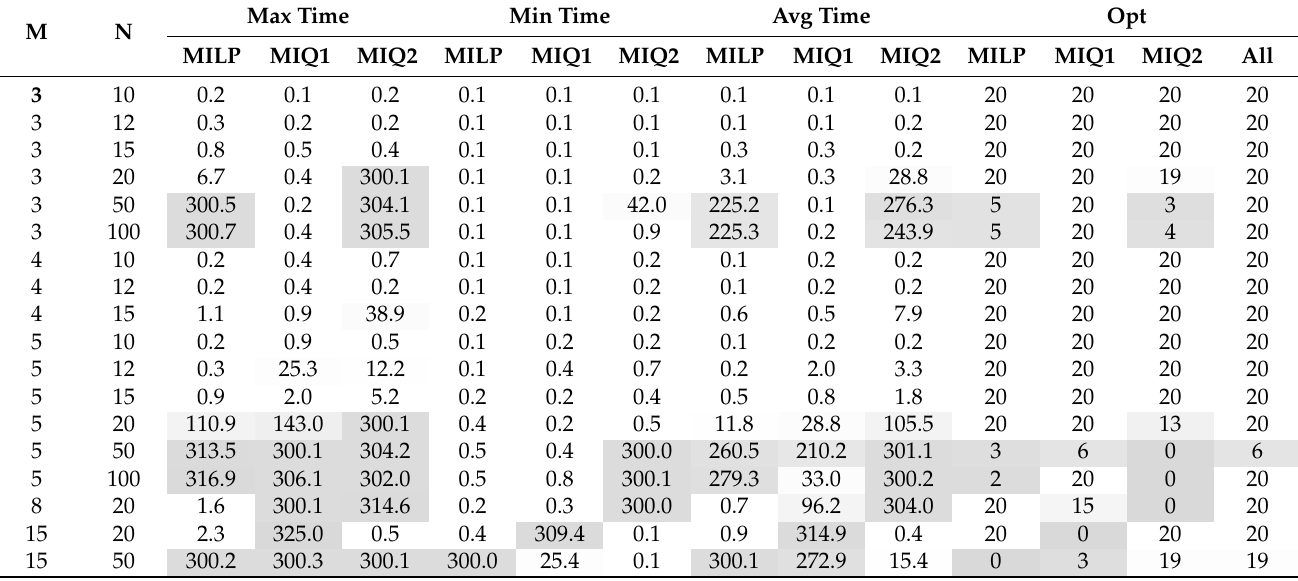
Table 3. Numerical results from the HGJ